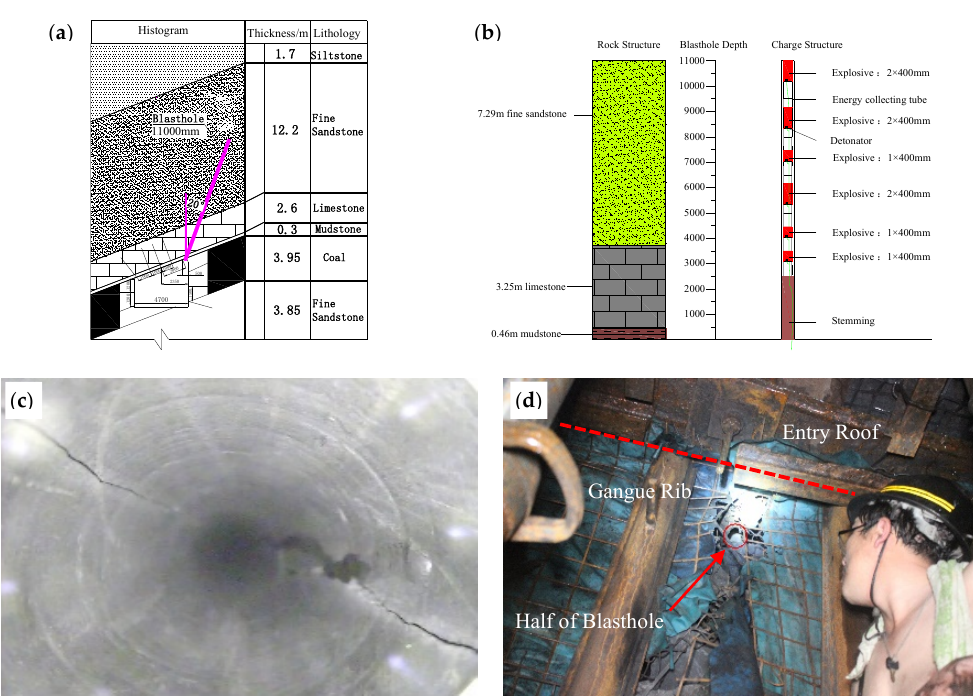
Figure 14. Design and construction of directional presplit blasting: ( a ) design of blasthole; ( b ) charge structure; ( c ) image of crack inside blasthole; ( d ) effect of goaf roof falling after blasting. Step 3: The entry roof of the section affected by dynamic pressure adopted the two orthogonal single hydraulic shed for temporary support. Along the direction of the entry section, a single hydraulic shed of one beam and four columns was arranged; the spacing of the columns was 2000, 1000, and 600 mm, and the row spacing was 800 mm. On the gangue rib side, along the entry, a single hydraulic shed of one beam and three columns was arranged, which was close to the U-shaped shed with column spacing of 1200 mm. After mining the working face, the temporary support was arranged in the entry to effectively control the entry deformation between roof and floor (Figure 15).